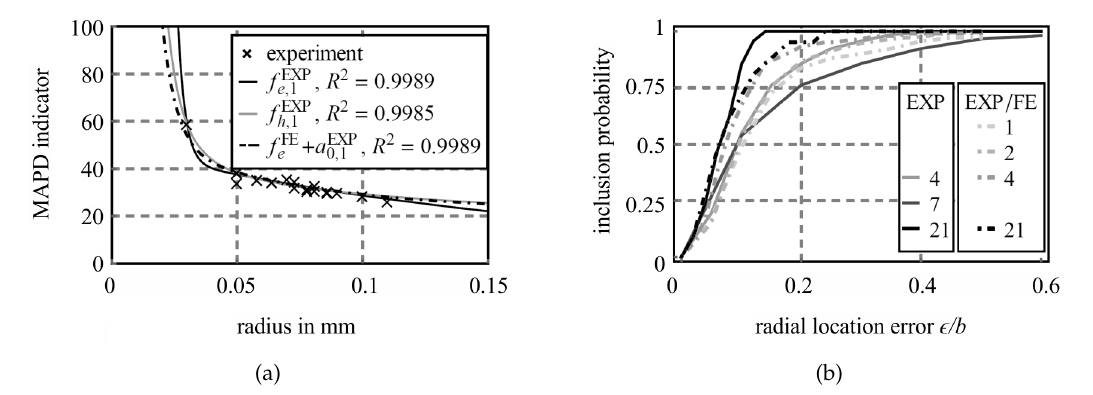
Figure 6. ( a ) MAPD damage indicator over distance r to the PWAS. The measurements are fitted (cid:12) (cid:12) ( 1 )( r ) (cid:12) (cid:12) FE = ae br , f EXP = a + a EXP with functions f EXP from measurements and simulations. (cid:12) H (cid:12) , and f e ,1 e ,1 0,1 h ,1 b ( b ) Comparison of cumulative probability that true damage locations are enclosed within a radius (cid:101) to the data-based (EXP) and model-based (EXP and FE) predicted damage location